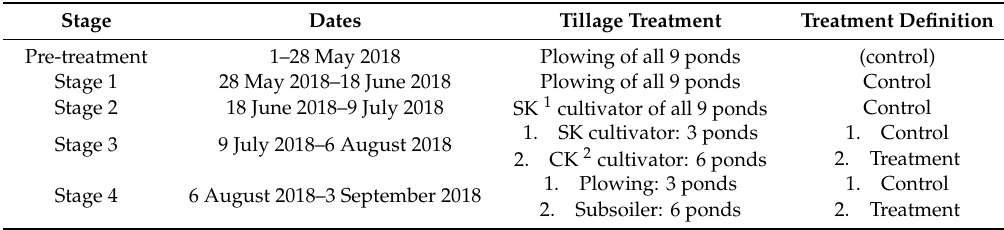
Figure 1. Schematic layout of the Yavne-2 recharge field with the operational pond’s sub-divisions, tested treatments (new tillage tools), control treatments (existing tillage tools), and ponds with soil compaction measurements. Table 1. The experiment’s progress and the tillage treatments applied. Each stage began with a tillage operation, followed by 6–19 recharge cycles.